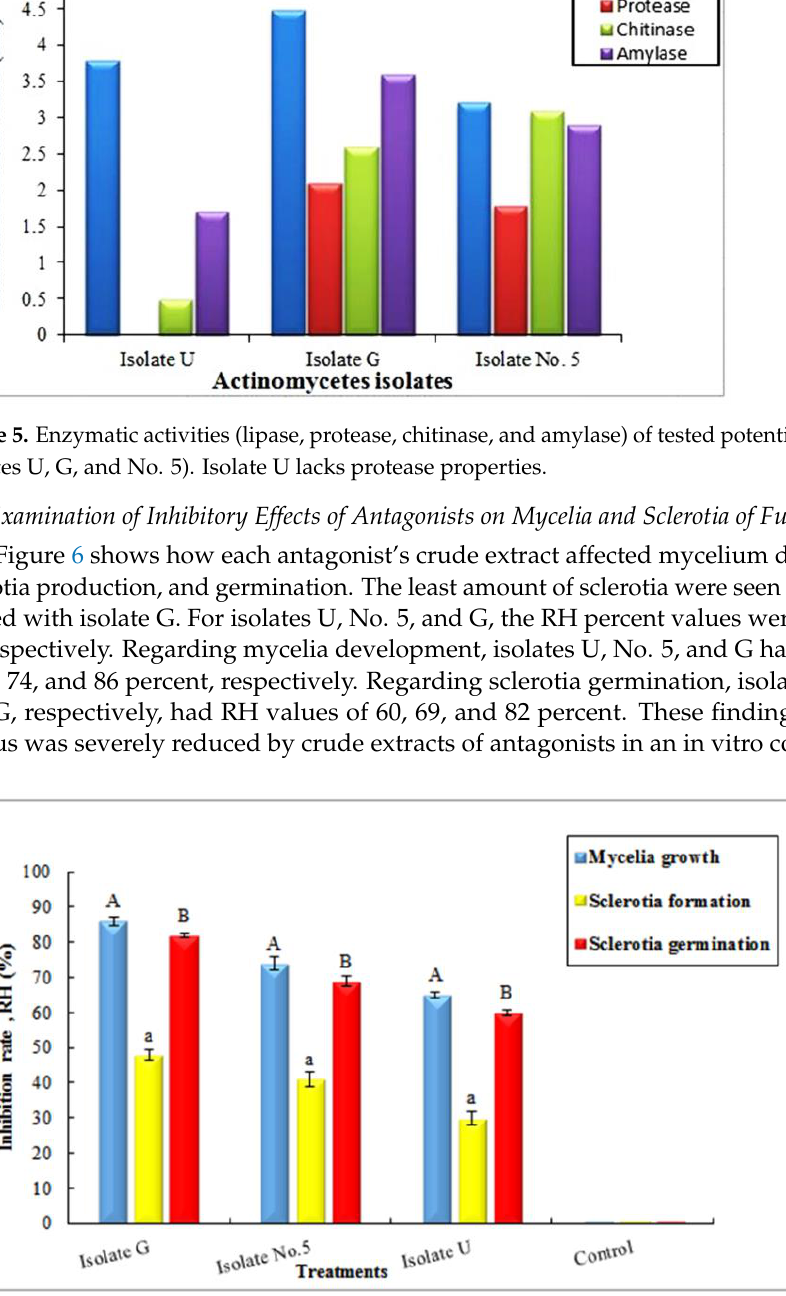
Figure 6. In vitro inhibition rate (RH%) of three antagonist effects on mycelia growth, sclerotia germination, and sclerotia formation against Rhizoctonia solani . The presented data are the means of three replications and the Duncan’s Multiple Range test ( p ≤ 0.05).